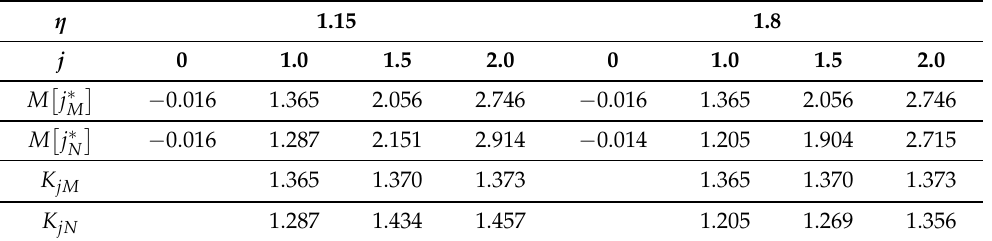
Table 4. The effective values of the mathematical expectation of the parameter estimates j .